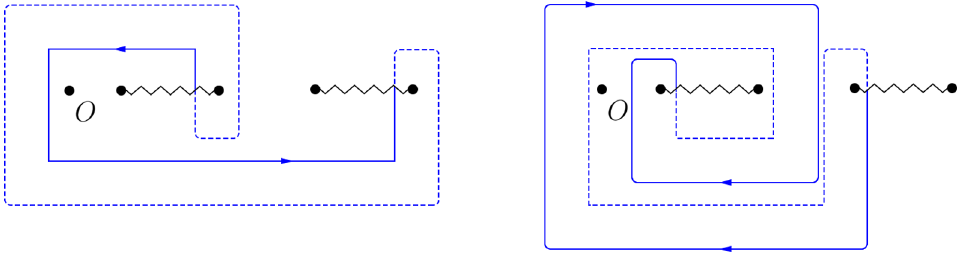
(left) and − B 0 12